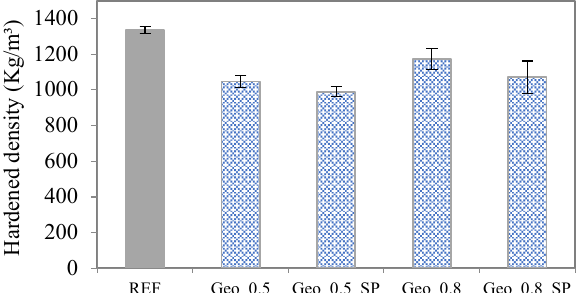
Figure 4. Hardened density of grouts studied.